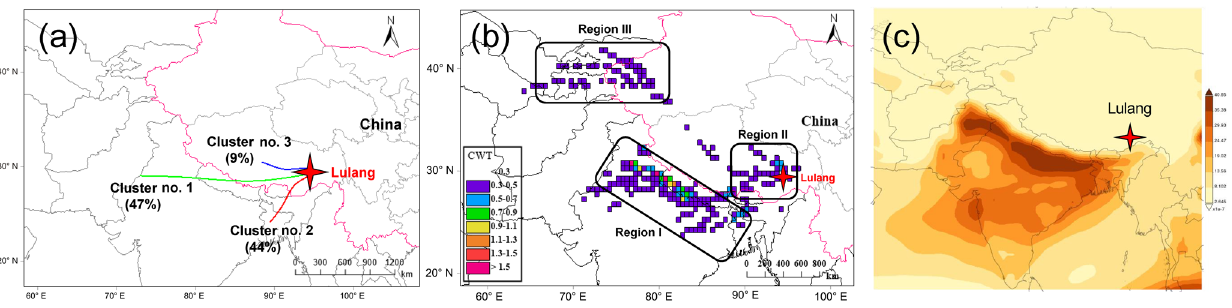
Figure 6. Maps of (a) the mean trajectory clusters, (b) the concentration-weighted trajectories (CWT, µgm − 3 ) for refractory black carbon mass concentrations, and (c) the reconstructed black carbon column mass densities (kgm − 2 ) during the campaign.